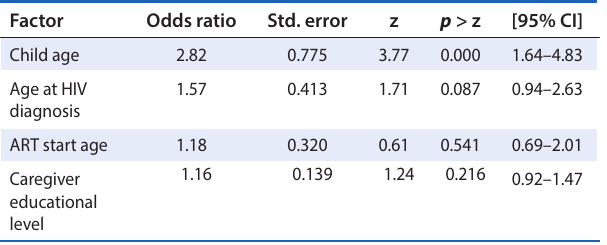
Table 5: Multivariate logistic regression of HIV disclosure to child Factor Odds ratio Std.